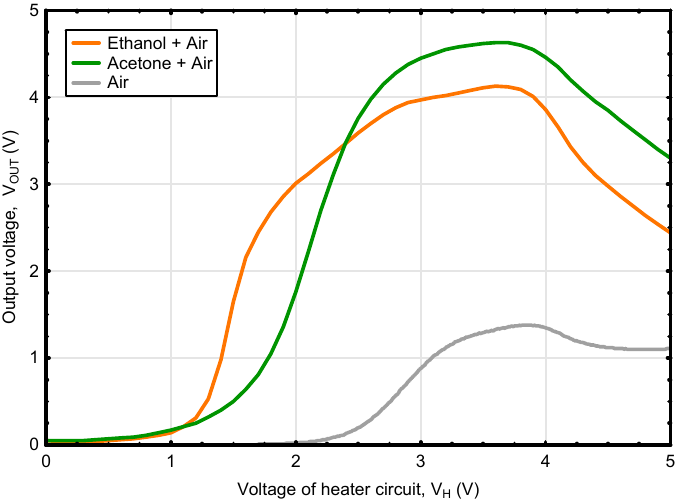
Figure 3. V OUT waveforms as a function of linearly increasing voltage (at rates of 0.5 V ∙ min − 1 ) of the micro-heater of the TGS2610-C gas sensor obtained individually for fresh air and for solutions containing maximal tested concentrations (0.5%) of individual analytes: ethanol or acetone.